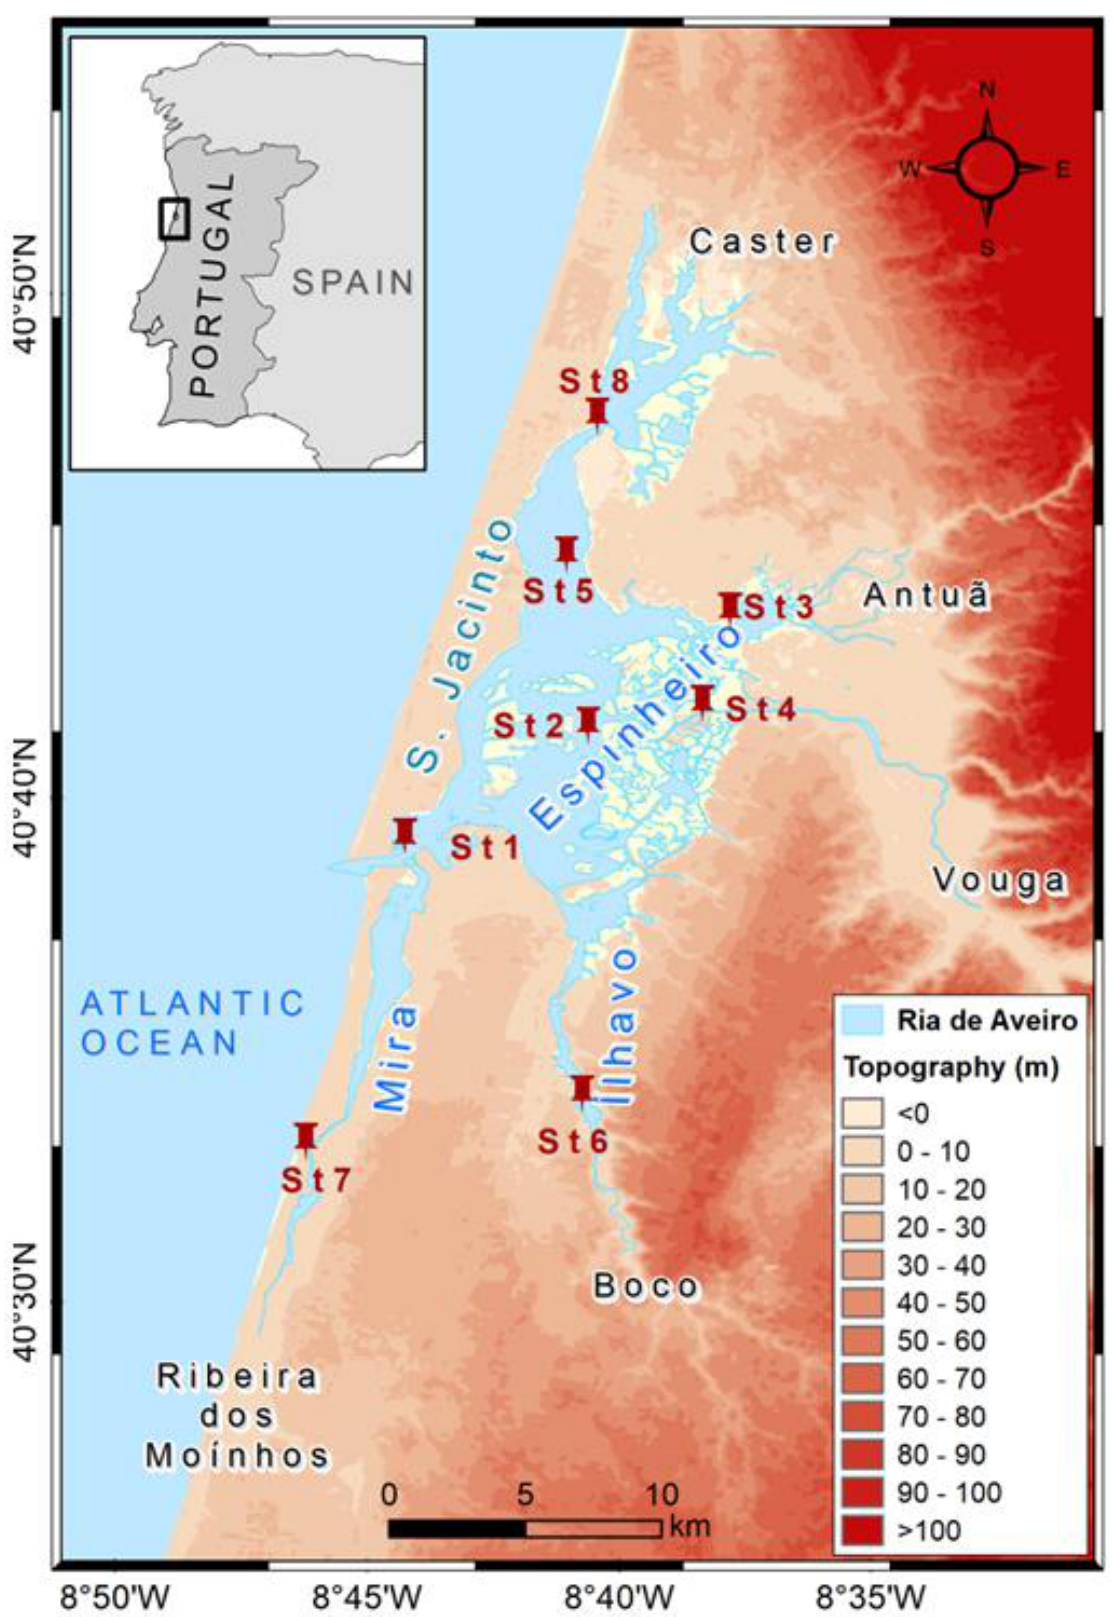
Figure 1. The study area: The Ria de Aveiro lagoon, with the location of the stations ( St1 – St8 ).